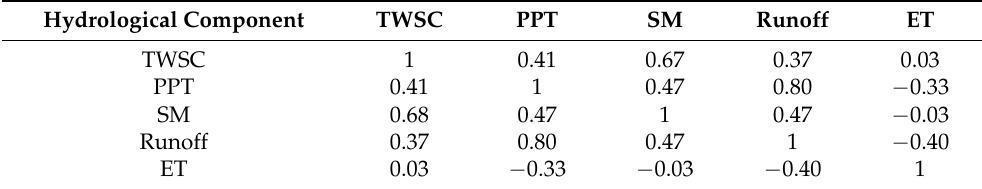
Table 5. The correlation coefficients between PPT, SM, ET, and runoff anomaly in the MLY (these results have passed the 95% confidence